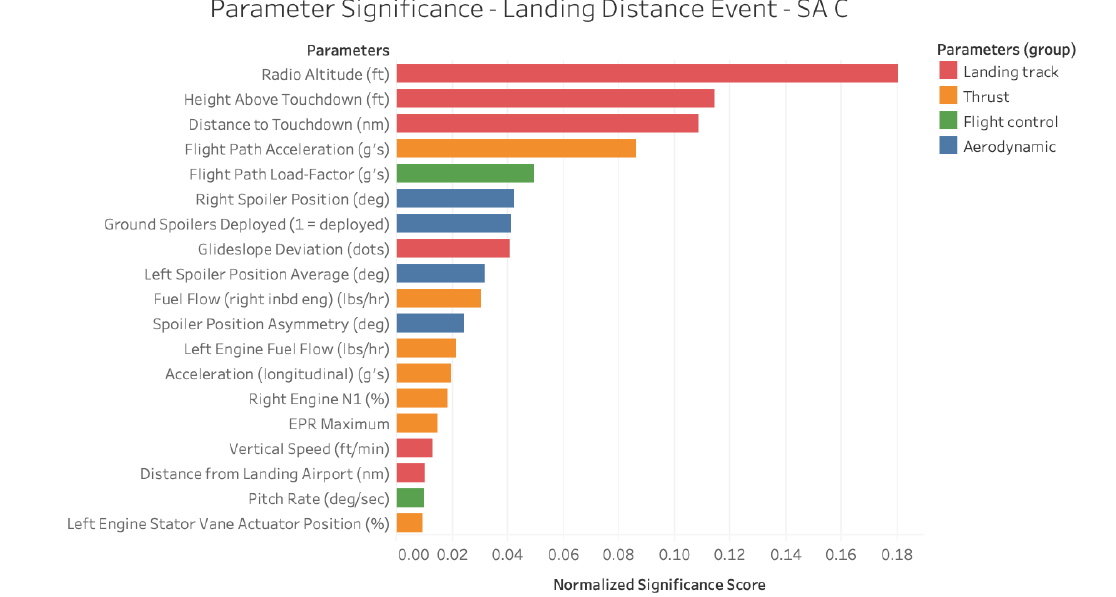
Figure 14. Normalized critical parameter significance for the Landing Distance Event for single-aisle airframe C obtained from application of SAFE